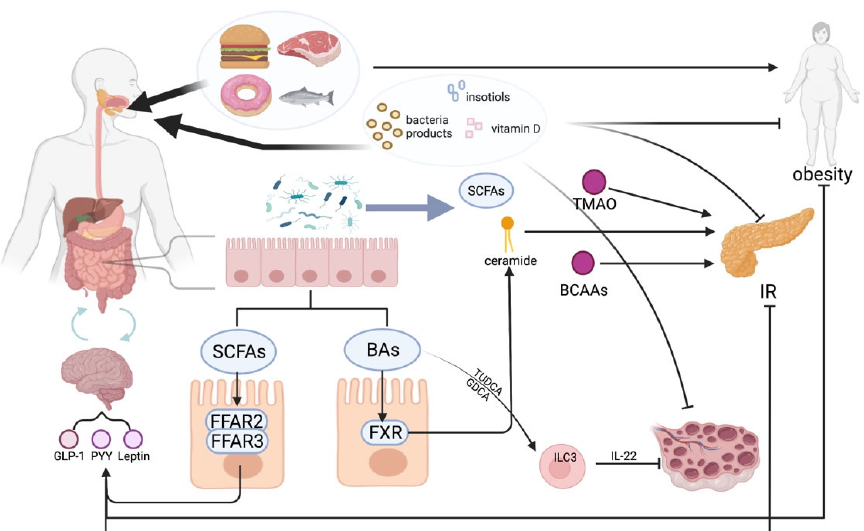
Figure 1. The role of some metabolites in the pathogenesis of PCOS. SCFAs: short-chain fatty acids, TMAO: Trimethylamine N-oxide, BCAAs: branched-chain amino acids, IR: insulin resistance, FFAR: fatty acid receptor, GLP-1: glucagon-like peptide-1, PYY: peptide YY, FXR: Farnesoid X receptor, TUDCA: tauroursodeoxycholic acid, GDCA: glycodeoxycholic acid, ILC3: intestinal Group 3 innate lymphoid cell.